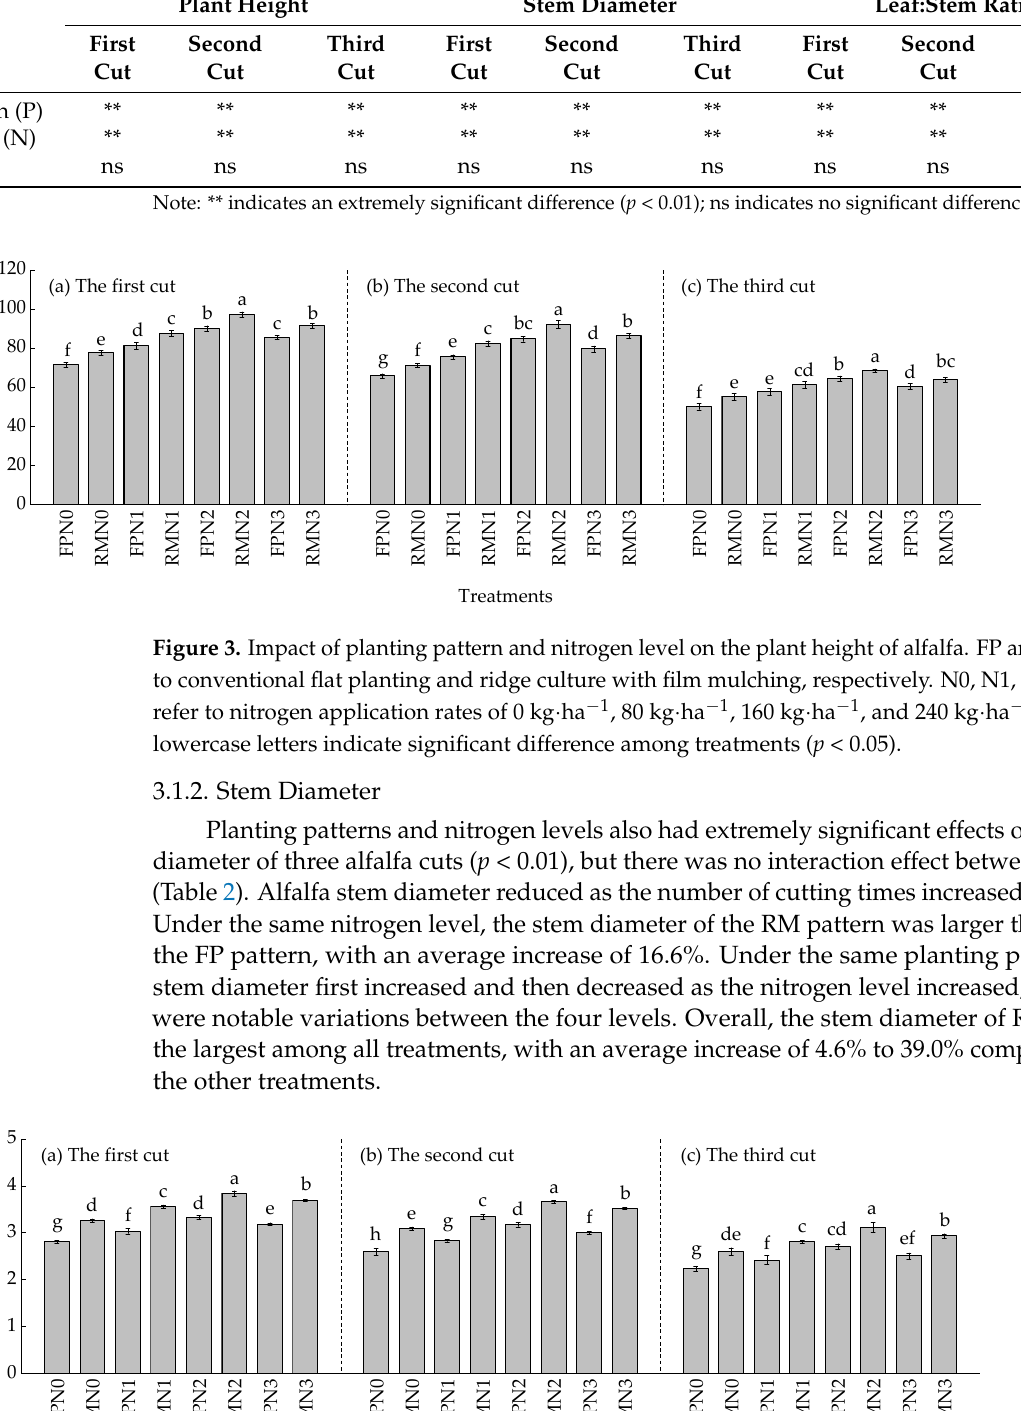
Table 2. Variance analysis of planting pattern and nitrogen level impact on the plant height, stem diameter, and leaf:stem ratio of alfalfa.